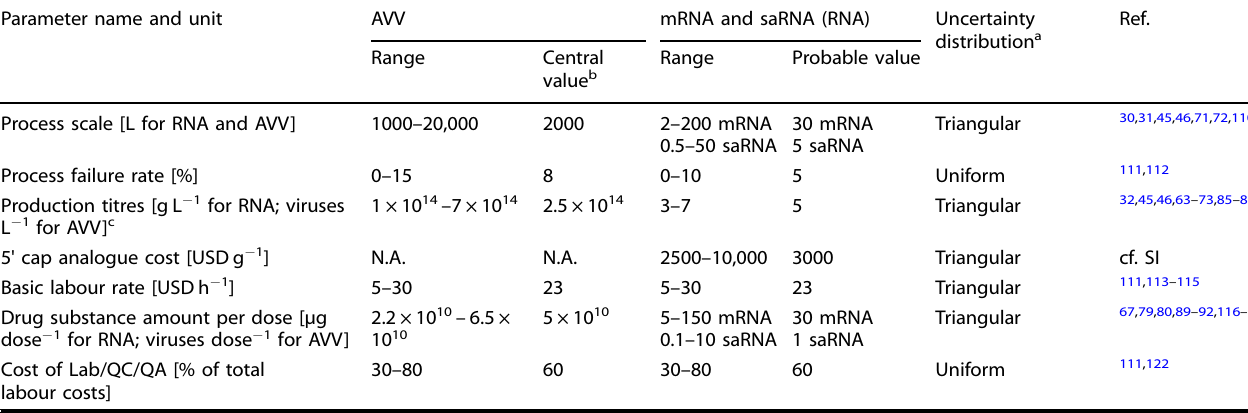
Table 1. Input factors in global sensitivity analysis of mRNA, saRNA and AVV vaccine drug substance production. Parameter name and